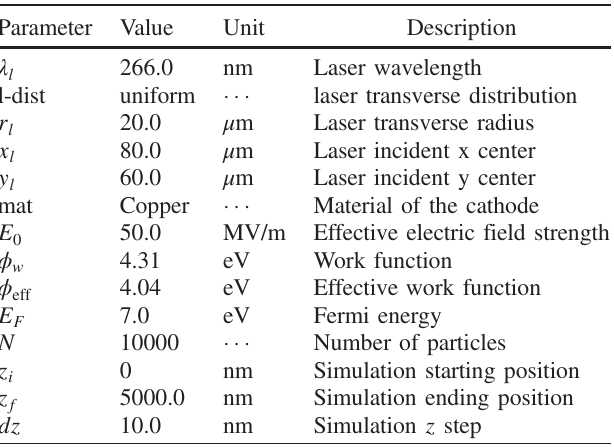
TABLE III. Parameters used in numerical simulation.